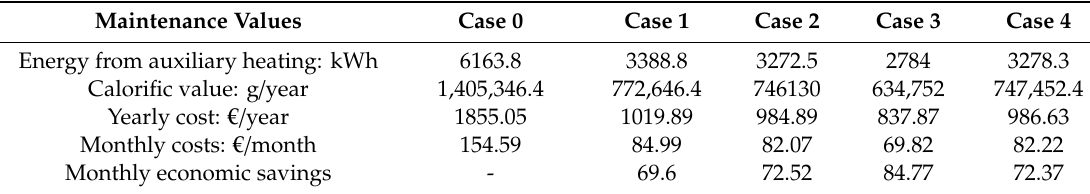
Table 5. Maintenance costs and economic savings for every case.